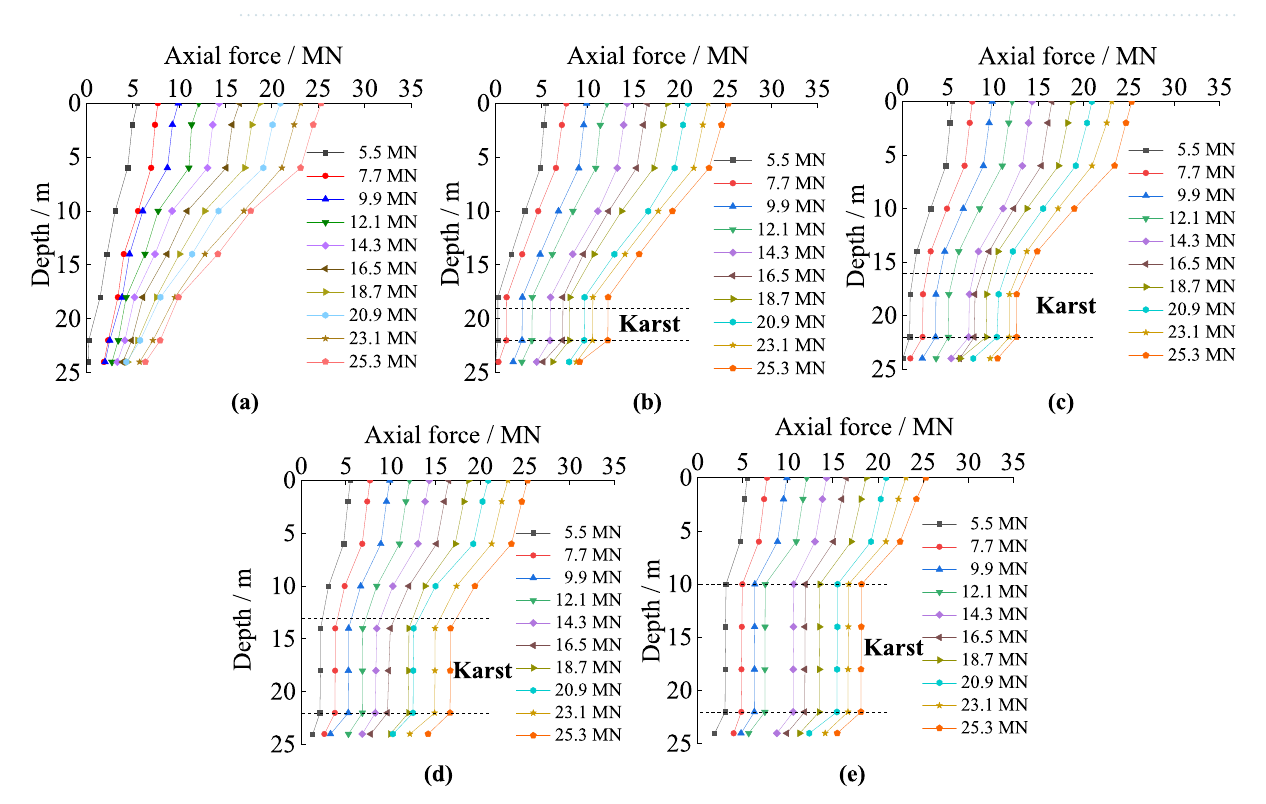
Figure 3. The axial force of piles with different karst cave heights: ( a ) no cave; ( b ) cave’s height is 3 m; ( c ) cave’s height is 6 m; ( d ) cave’s height is 9 m; ( e ) cave’s height is 12